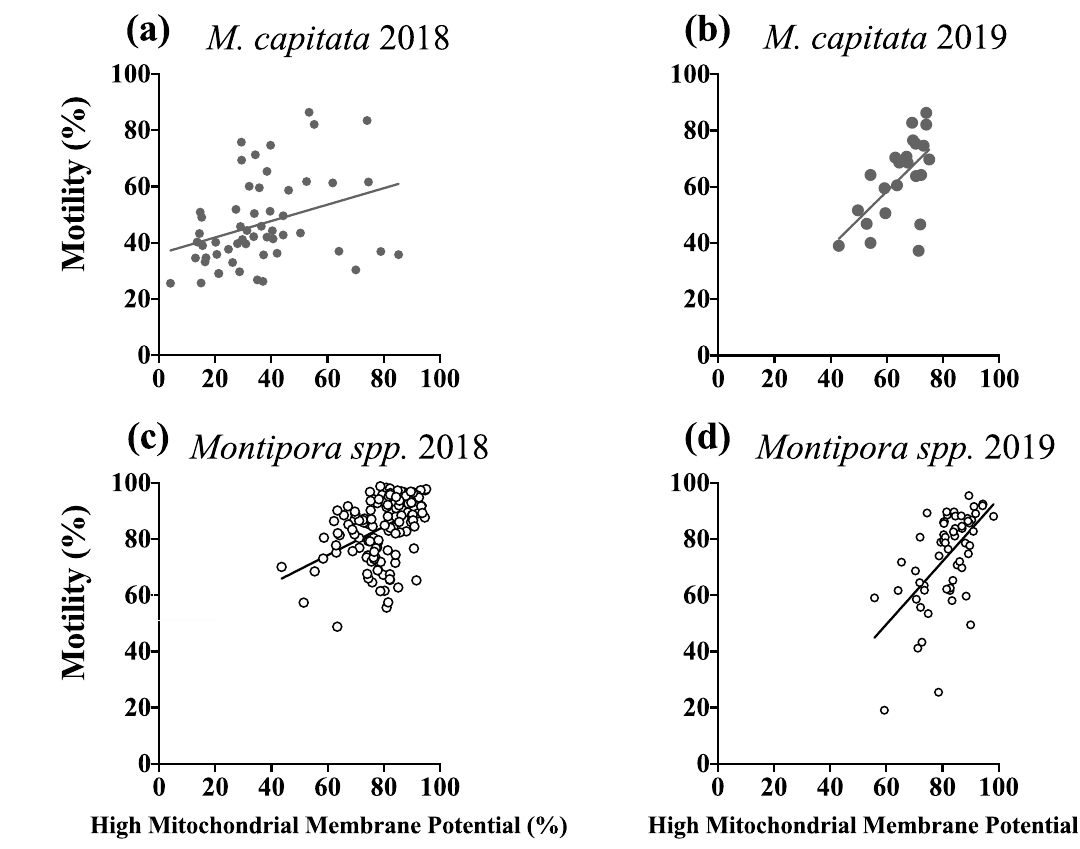
Figure 6. Correlation of percent sperm motility with percent of sperm with high mitochondrial integrity. ( a ) In 2018 M . capitata , approximately 10% of the variation is shared between motility and membrane potential (n = 55, R 2 = 0.1025, p = 0.0172). ( b ) In 2019 M . capitata , that increased to 37% of the variance shared ( b n = 23, R 2 = 0.3715, p = 0.002) . ( c ) In 2018 Montipora spp. , about 22% of the variance is shared between motility and membrane integrity (n = 137, R 2 = 0.2160, p < 0.0001). ( d ) In 2019 Montipora spp. , that increased to 37% of the variance shared between the two (n = 61, R 2 = 0.3655, p < 0.0001). (GraphPad Prism 9 v. 9.0.1; San Diego, CA, USA, www. graph pad.